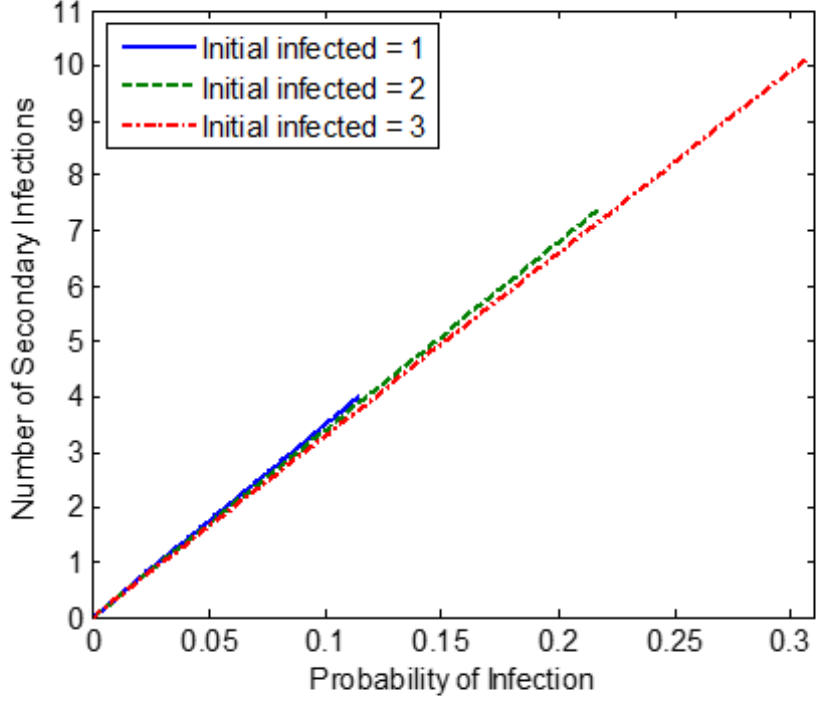
Figure 10. The number of secondary infections in the train coach (ladies compartment) due to the introduction of infected individuals into the susceptible population (total population of N = S + I = 36), shown as a function of the estimated probability of